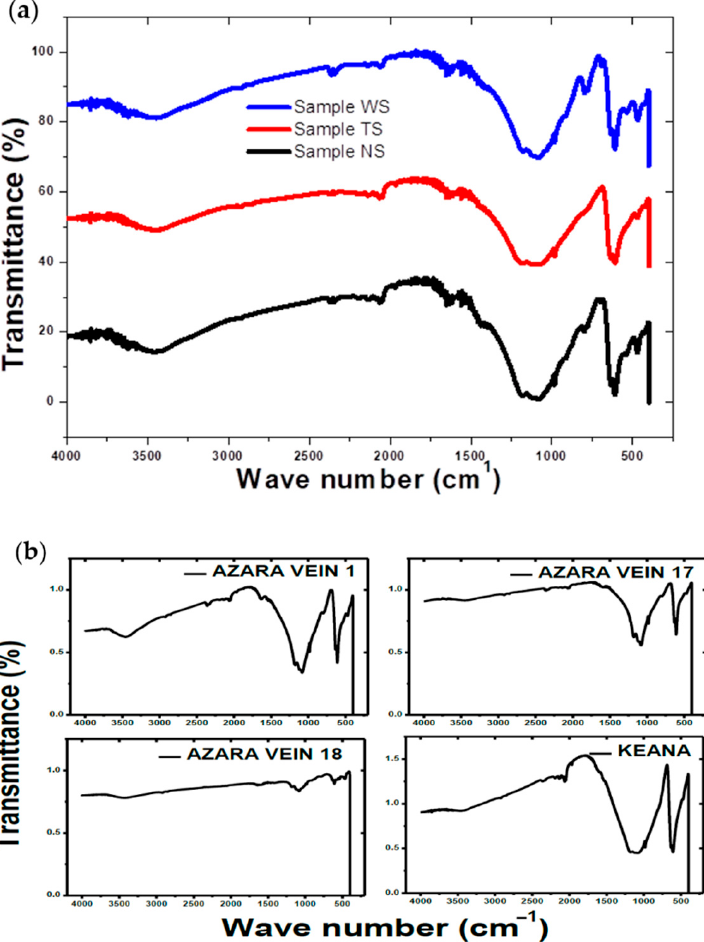
Figure 3. ( a ) FTIR spectra for the barite samples from different mining sites; ( b ) FTIR spectra for the barite samples from different mining